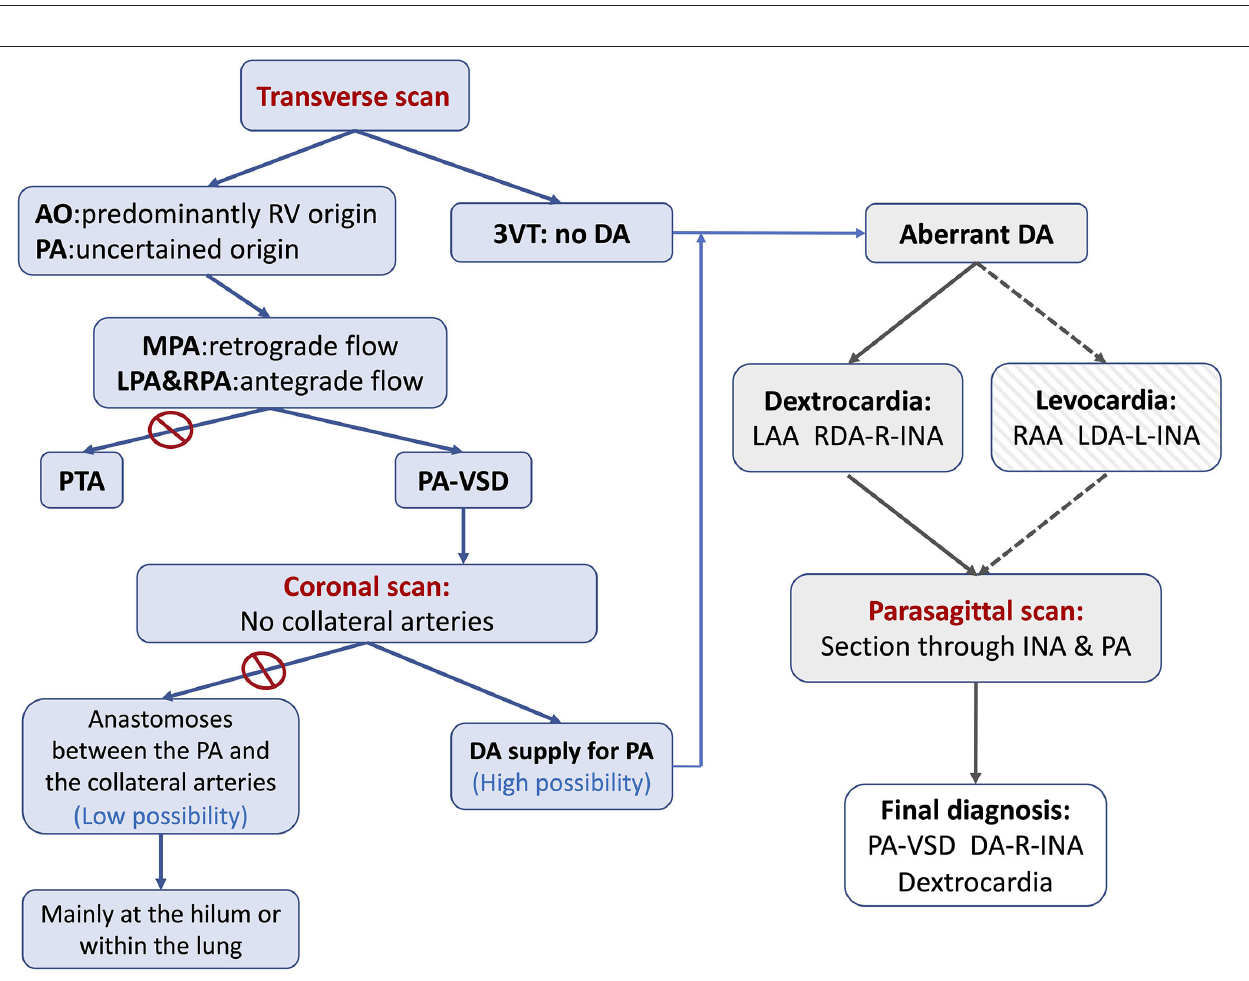
FIGURE 4 | The flowchart summarizing the steps of the diagnosis of PA-VSD with an aberrant ductus in the current case study. The first step is to determine the blood supply to the pulmonary artery. The retrograde flow in MPA together with the antegrade flow in LPA and RPA suggests the DA-PA supplying pattern. The second step is to show (or rule out) any collateral artery by scanning the coronal plane sectioned through the bilateral hilum. The third step is to search for and trace the origin, course, and connection of the aberrant ductus, if existent. As the ductus may be connected to the L-INA in a mirror-imaging RAA fetus (Levocardia and RAA), there may be in existence a ductus connecting the R-INA with the pulmonary artery in the current case (Dextrocardia and LAA). An intended parasagittal scanning sectioned through the base of R-INA does the work. 3VT, three-vessel trachea view; AO, aorta; DA, ductus arteriosus; LAA, left aortic arch; LDA, left ductus arteriosus; L-INA, left innominate artery; LPA, left pulmonary artery; MPA, main pulmonary artery; PA, pulmonary artery; PA-VSD, pulmonary atresia with ventricular septal defect; PTA, persistent truncus arteriosus; RAA, right aortic arch; RDA, right ductus arteriosus; R-INA, right innominate artery; RPA, right pulmonary